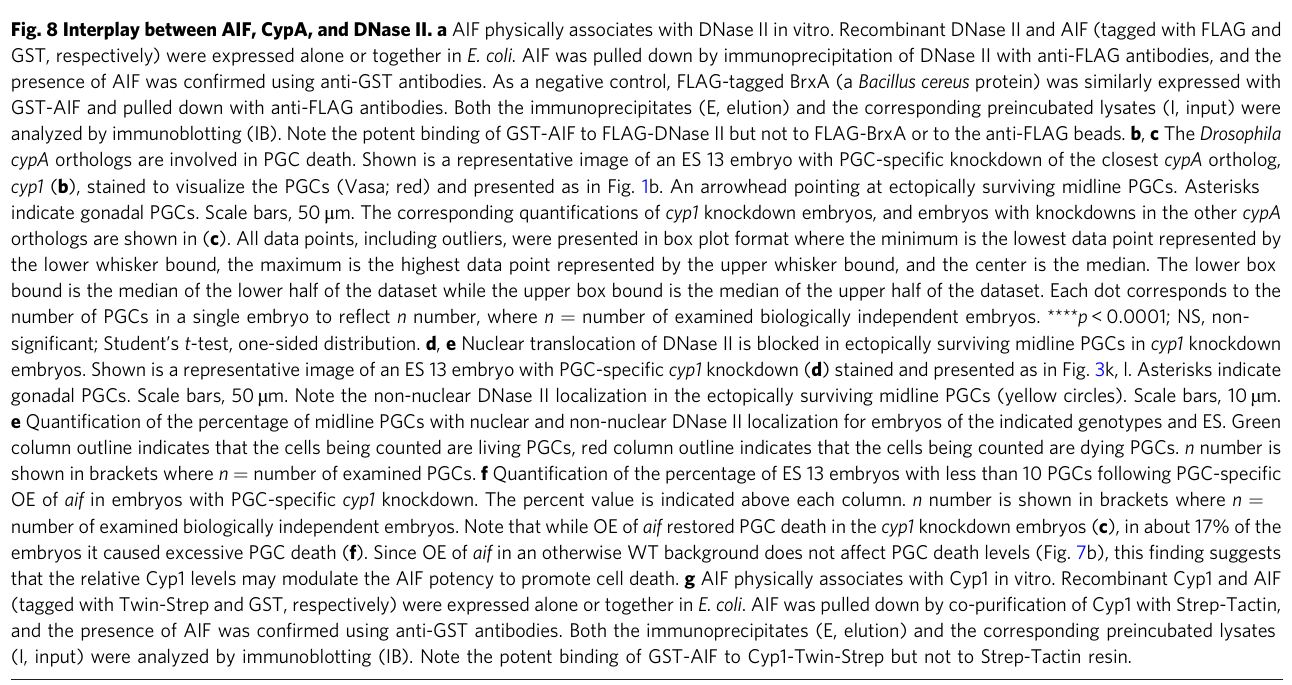
Fig. 8 Interplay between AIF, CypA, and DNase II. a AIF physically associates with DNase II in vitro. Recombinant DNase II and AIF (tagged with FLAG and GST, respectively) were expressed alone or together in E. coli . AIF was pulled down by immunoprecipitation of DNase II with anti-FLAG antibodies, and the presence of AIF was con fi rmed using anti-GST antibodies. As a negative control, FLAG-tagged BrxA (a Bacillus cereus protein) was similarly expressed with GST-AIF and pulled down with anti-FLAG antibodies. Both the immunoprecipitates (E, elution) and the corresponding preincubated lysates (I, input) were analyzed by immunoblotting (IB). Note the potent binding of GST-AIF to FLAG-DNase II but not to FLAG-BrxA or to the anti-FLAG beads. b , c The Drosophila cypA orthologs are involved in PGC death. Shown is a representative image of an ES 13 embryo with PGC-speci fi c knockdown of the closest cypA ortholog, cyp1 ( b ), stained to visualize the PGCs (Vasa; red) and presented as in Fig. 1b. An arrowhead pointing at ectopically surviving midline PGCs. Asterisks indicate gonadal PGCs. Scale bars, 50 μ m. The corresponding quanti fi cations of cyp1 knockdown embryos, and embryos with knockdowns in the other cypA orthologs are shown in ( c ). All data points, including outliers, were presented in box plot format where the minimum is the lowest data point represented by the lower whisker bound, the maximum is the highest data point represented by the upper whisker bound, and the center is the median. The lower box bound is the median of the lower half of the dataset while the upper box bound is the median of the upper half of the dataset. Each dot corresponds to the number of PGCs in a single embryo to re fl ect n number, where n = number of examined biologically independent embryos. **** p < 0.0001; NS, non- signi fi cant; Student ’ s t -test, one-sided distribution. d , e Nuclear translocation of DNase II is blocked in ectopically surviving midline PGCs in cyp1 knockdown embryos. Shown is a representative image of an ES 13 embryo with PGC-speci fi c cyp1 knockdown ( d ) stained and presented as in Fig. 3k, l. Asterisks indicate gonadal PGCs. Scale bars, 50 µ m. Note the non-nuclear DNase II localization in the ectopically surviving midline PGCs (yellow circles). Scale bars, 10 µ m. e Quanti fi cation of the percentage of midline PGCs with nuclear and non-nuclear DNase II localization for embryos of the indicated genotypes and ES. Green column outline indicates that the cells being counted are living PGCs, red column outline indicates that the cells being counted are dying PGCs. n number is shown in brackets where n = number of examined PGCs. f Quanti fi cation of the percentage of ES 13 embryos with less than 10 PGCs following PGC-speci fi c OE of aif in embryos with PGC-speci fi c cyp1 knockdown. The percent value is indicated above each column. n number is shown in brackets where n = number of examined biologically independent embryos. Note that while OE of aif restored PGC death in the cyp1 knockdown embryos ( c ), in about 17% of the embryos it caused excessive PGC death ( f ). Since OE of aif in an otherwise WT background does not affect PGC death levels (Fig. 7b), this fi nding suggests that the relative Cyp1 levels may modulate the AIF potency to promote cell death. g AIF physically associates with Cyp1 in vitro. Recombinant Cyp1 and AIF (tagged with Twin-Strep and GST, respectively) were expressed alone or together in E. coli . AIF was pulled down by co-puri fi cation of Cyp1 with Strep-Tactin, and the presence of AIF was con fi rmed using anti-GST antibodies. Both the immunoprecipitates (E, elution) and the corresponding preincubated lysates (I, input) were analyzed by immunoblotting (IB). Note the potent binding of GST-AIF to Cyp1-Twin-Strep but not to Strep-Tactin